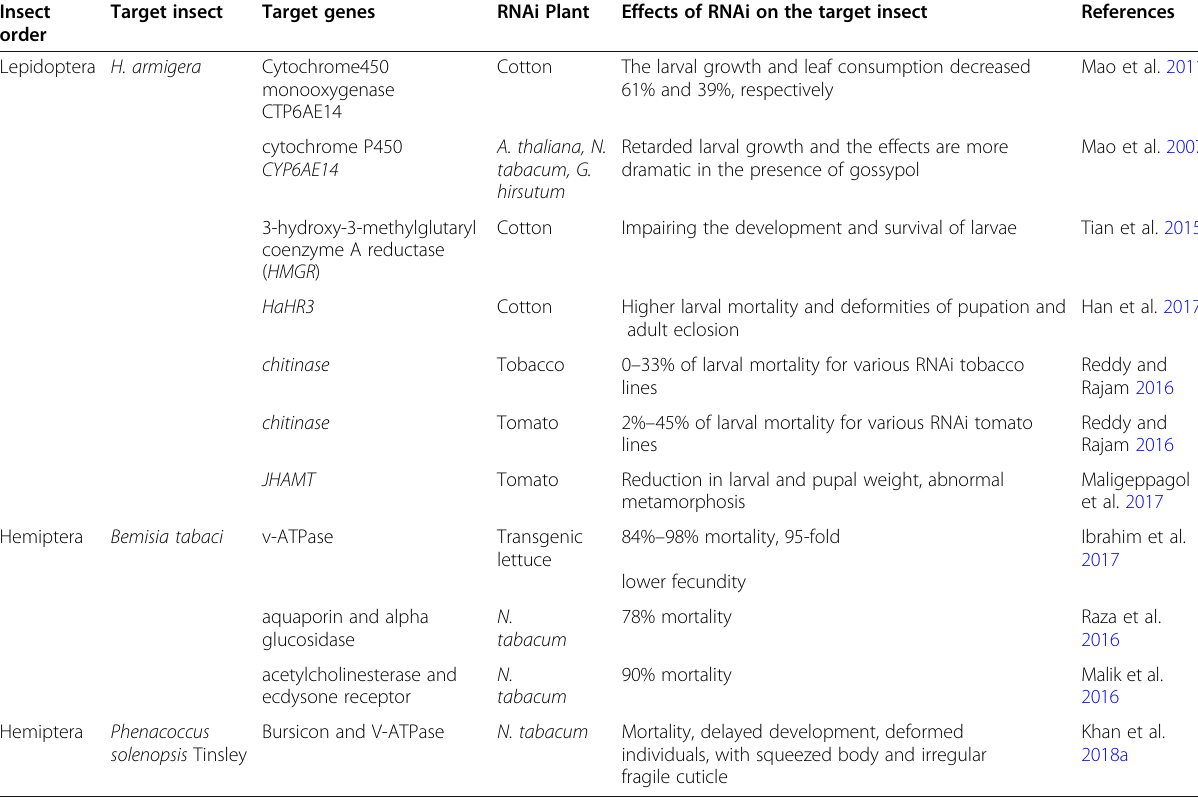
Table 2 Successful cases of plant mediated RNAi in different cotton pests Insect